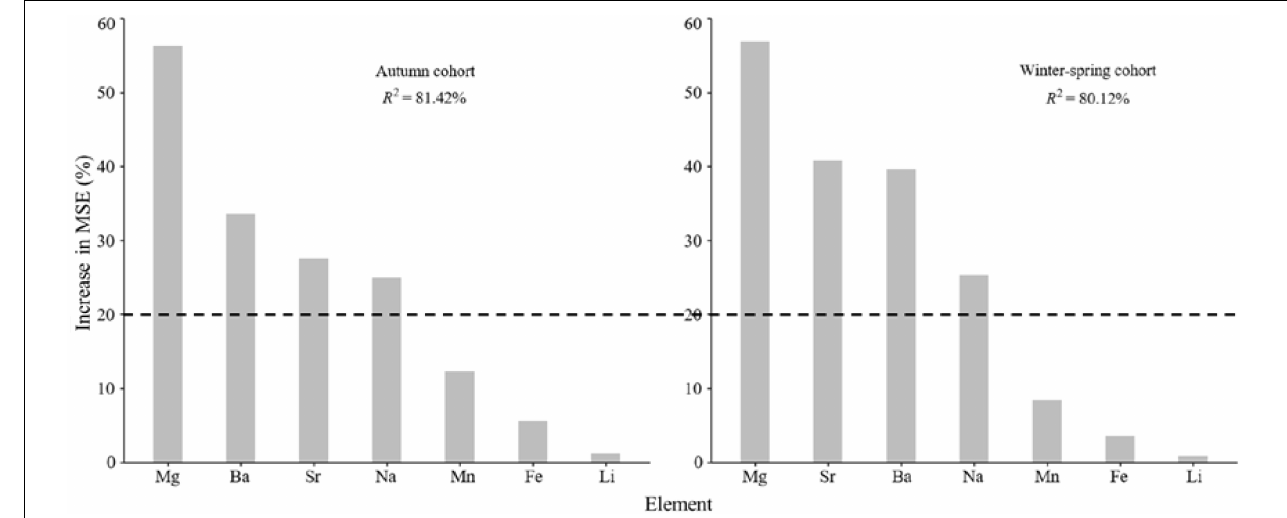
FIGURE 3 | Relative importance of elements of statolith for autumn and winter-spring cohorts. Percentage increases in the mean squared error (MSE) of variables were used to estimate the importance of these predictors, and higher MSE% values imply more important predictors.